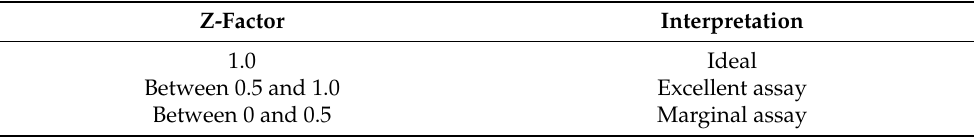
Table 2. Interpretation of the calculation of the Z’factor. Z-Factor Interpretation 1.0 Ideal Between 0.5 and 1.0 Excellent assay Between 0 and 0.5 Marginal